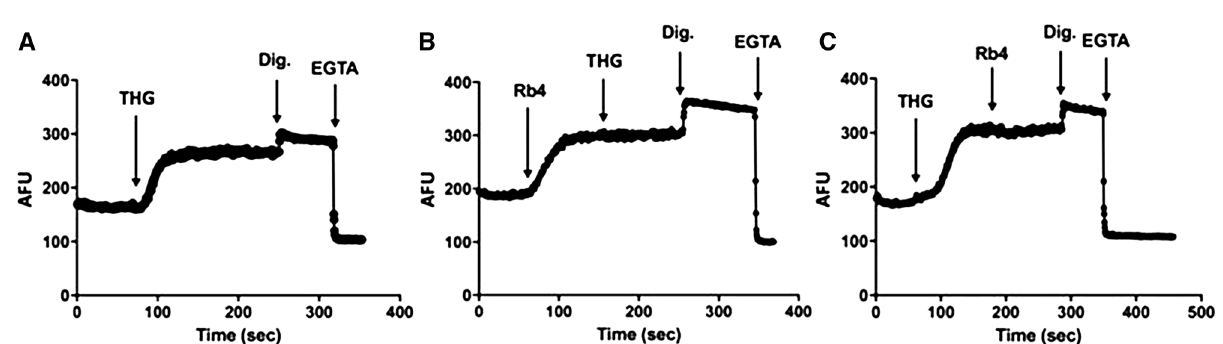
Figure 7. Endoplasmic reticulum calcium flux increased by Rb4. B16F10-Nex2 cells were treated ( A ) with thapsigargin, digitonin and EGTA or ( B ) 0.15 mM Rb4 followed by thapsigargin, digitonin and EGTA or ( C ) with thapsigargin followed by 0.15 mM Rb4, digitonin and EGTA. AFU: Fluo-4 arbitrary fluorescence units. THG: Thapsigargin; Dig: to regulate RIP1-independent necrotic death on U87MG cells expressing Bcl-xL elicited by a non-selective iso- peptidase inhibitor 28 .